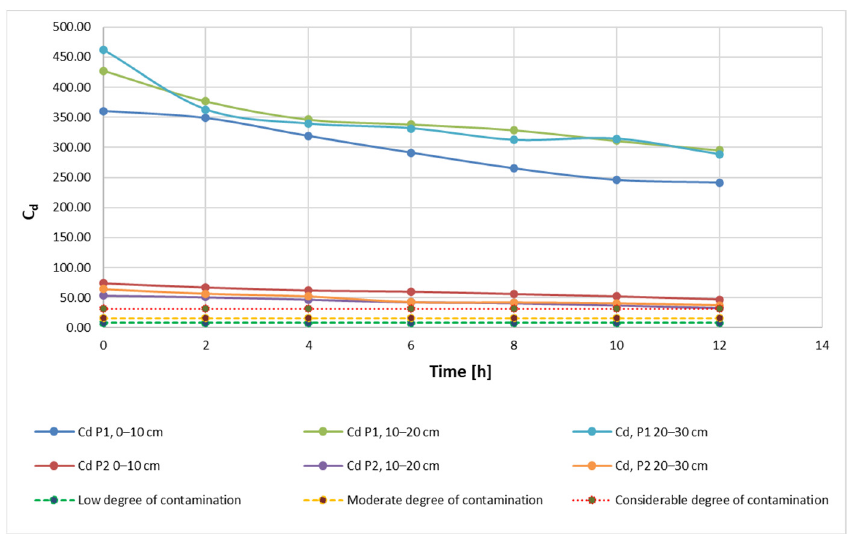
Figure 7. C d —degree of contamination during the extraction process according to the admissibility limits and sampling depth using 40 mL 9K medium.